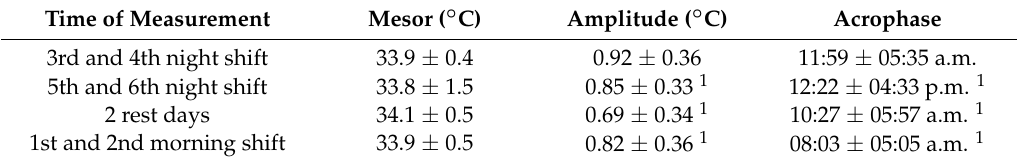
Table 3. Cosinor analysis of the wrist-skin temperature among shift workers. Time of